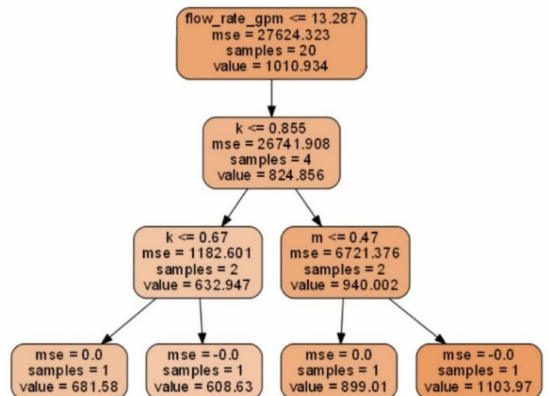
Figure A5. Single leaf node of tree-based model in random forest with various decision